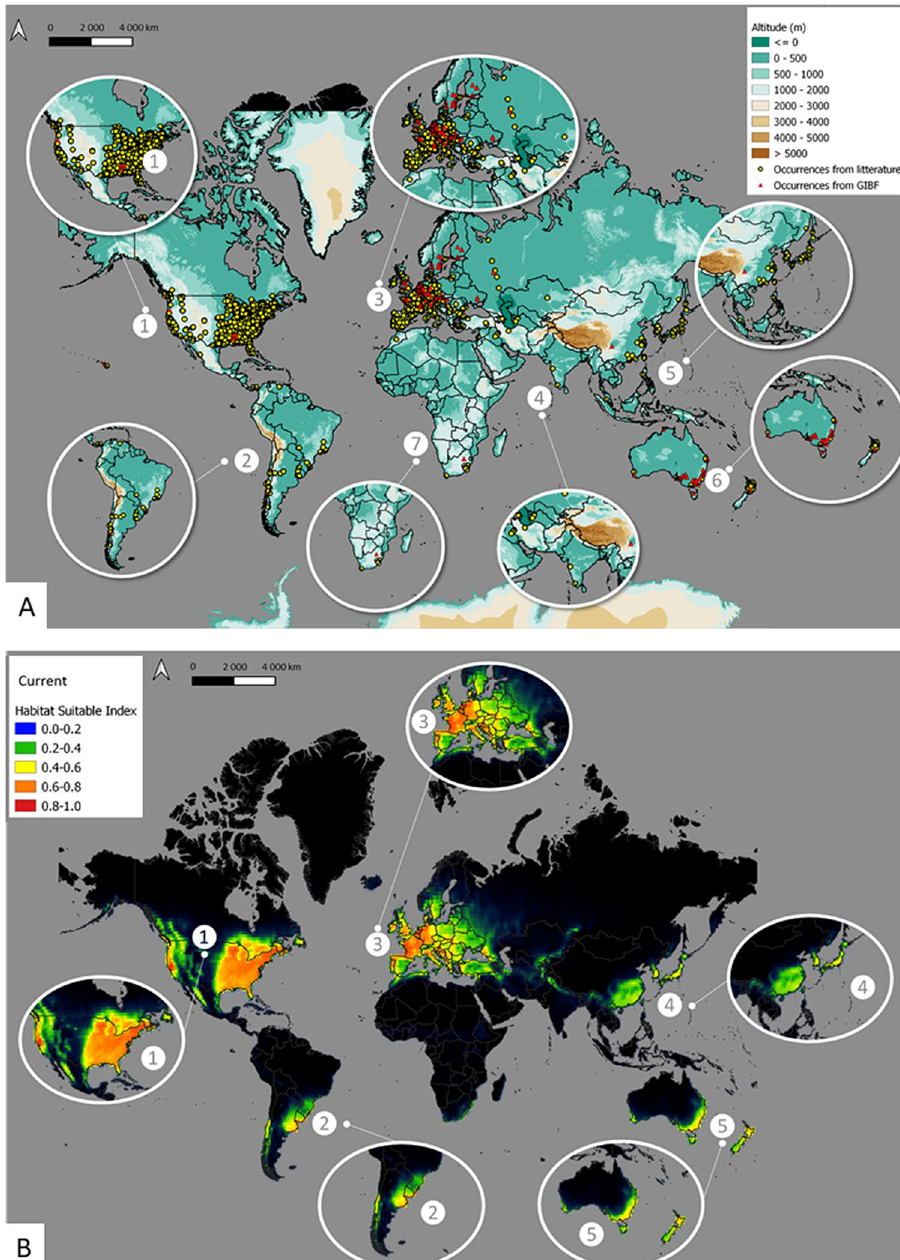
Figure 2. Distribution of Craspedacusta sowerbii ( A ) current occurrences and ( B ) predicted distribution under current climate conditions using Maxent at the global scale. Map produced using QGIS version 3.16.3 software, https:// www. qgis. org/ fr/ site/ index. html. Occurrences (graph A) were extracted from the database PANGAEA 64